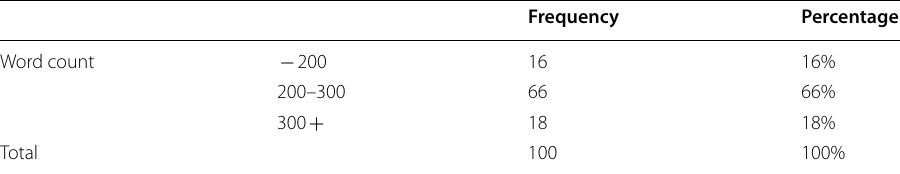
Table 2 Details of the corpus